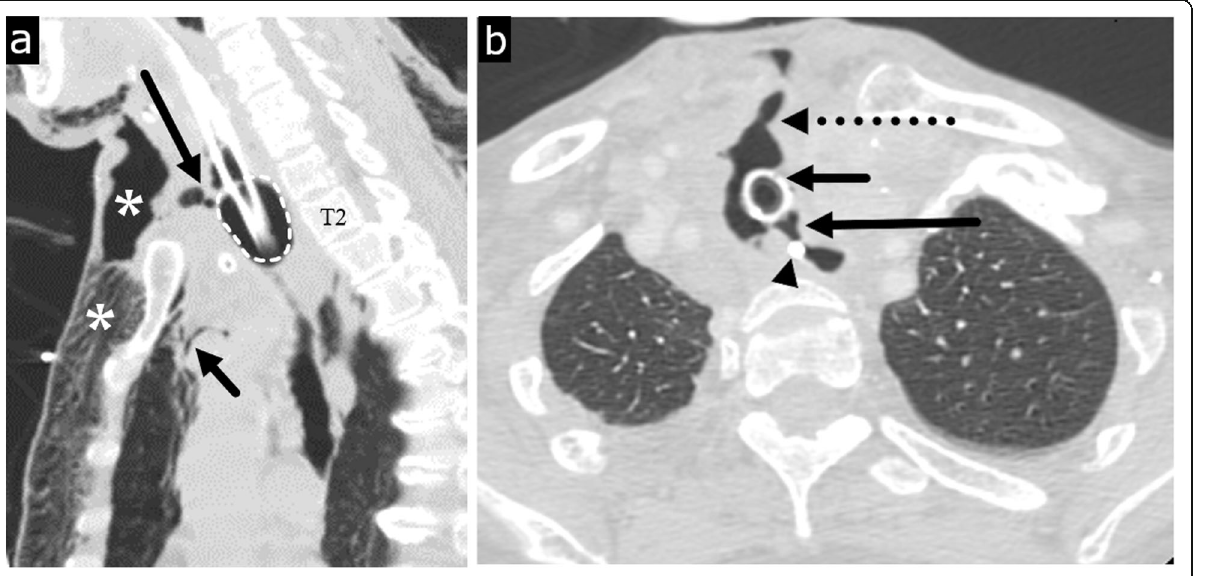
Fig. 6 Tracheoesophageal fistula. Ninety-one-year-old female with long term intubation with subcutaneous crepitus. a Sagittal CT image shows a traumatic anterior tracheal wall defect (long black arrow) caused by an overinflated endotracheal tube balloon (dotted circle) resulting in a tracheocutaneous fistula and severe anterior chest wall subcutaneous emphysema (asterisks). Small pneumomediastinum (short black arrow) is seen. b Axial CT image obtained 3 weeks later shows a new tracheoesophageal fistula in the region of the previous overinflated endotracheal tube balloon (long black arrow), and a persistent tracheocutaneous fistula (dashed black arrow). Tracheostomy tube (short black arrow). Enteric tube